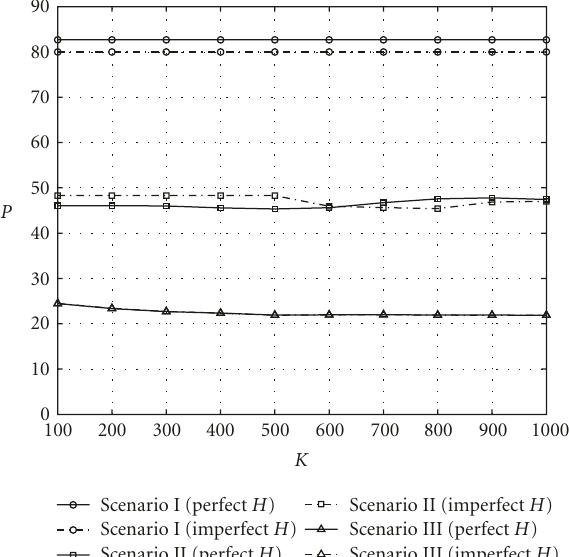
Figure 9: The power consumption (defined in (10)) per source bit. The curves with circle-mark are for Scenario I, the curves with square-mark are for Scenario II, and the curves with triangle- mark are for Scenario III. The solid curve is with perfect channel knowledge and the dash-dot line is without channel knowledge.